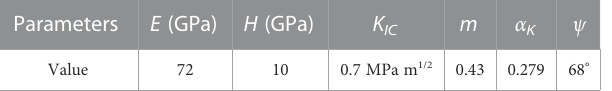
TABLE 2 Fracture mechanical property parameters of quartz glass (Lambropoulos et al., 1999). Parameters